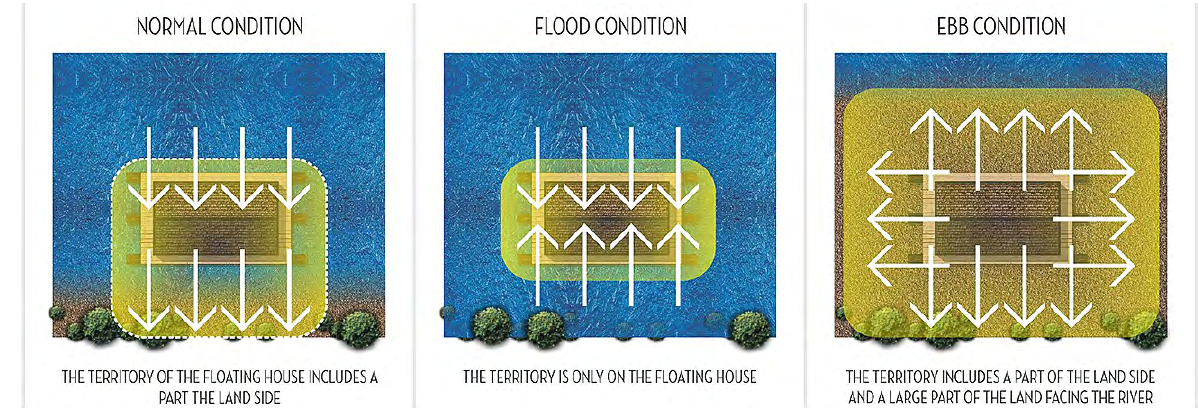
Figure 15. Privacy modification in floating